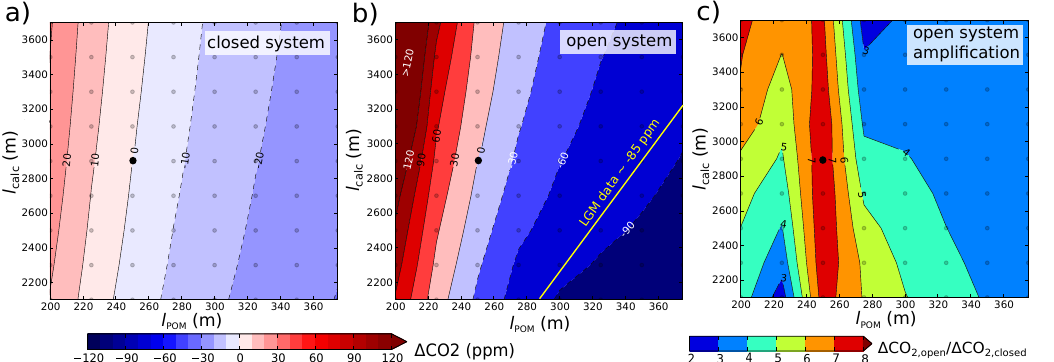
Figure 9. 1 CO 2 as a function of the length scale for the remineralisation of POM ( l POM ) and the length scale for the dissolution of CaCO 3 ( l calc ). Values are differences with respect to the control experiment with l POM = 250m and l calc = 2900m (black dots) and for equilibrium (see main text). Remineralisation/redissolution lengthscale changes are altered globally in these experiments. (a) is for a closed system, and (b) for an open system, i.e. a setup allowing for weathering–burial dynamics. The LGM CO 2 anomaly w.r.t. the Holocene ( ∼ 85ppm) is indicated by the yellow line. (c) shows the amplification of CO 2 changes due to weathering–burial